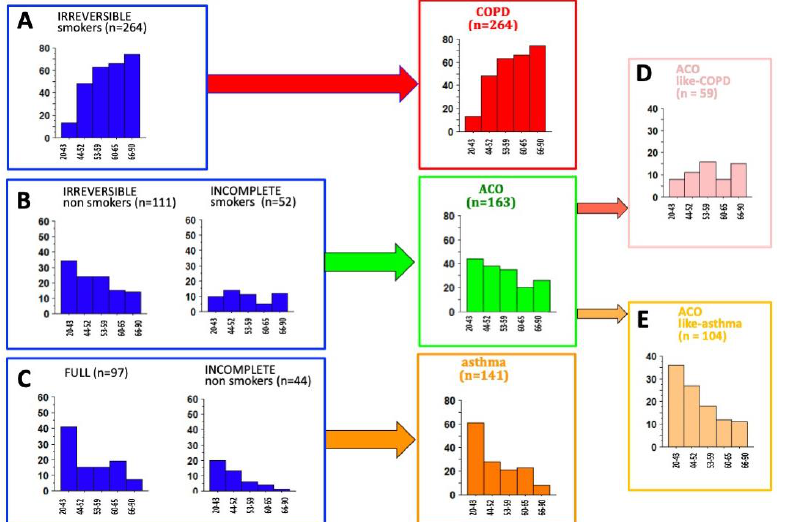
Figure A1. Definition and prevalence of 5 phenotypes of obstructive airway diseases based on bron- chial reversibility defined as a >10% change of FEV1 predicted value. FEV 1 : forced expiratory vol- ume in 1 s; FVC: forced vital capacity. BD: bronchodilator; COPD: chronic obstructive pulmonary